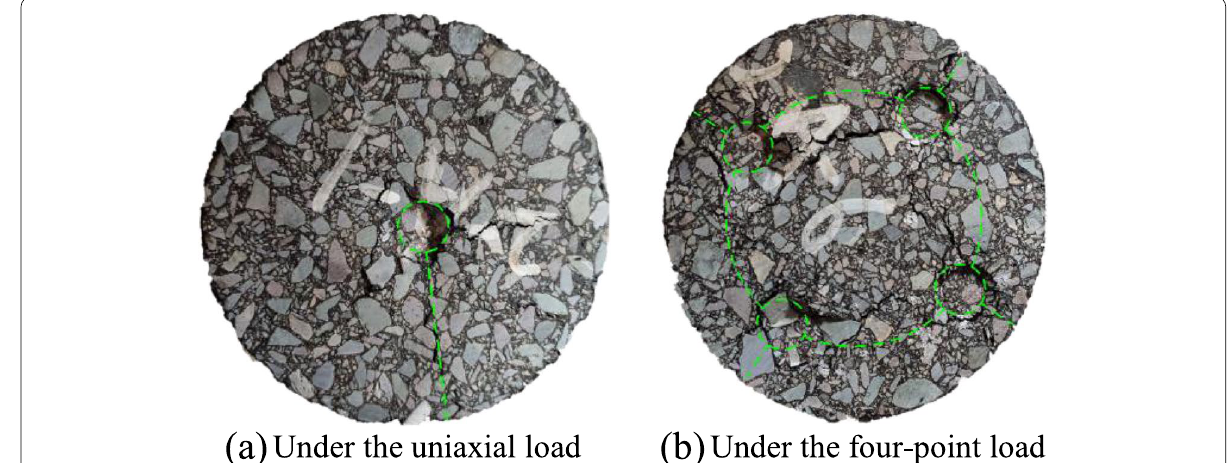
Fig. 8 Crack patterns of SMA-13 mixture. ( a ) Under the uniaxial load. ( b ) Under the four-point load